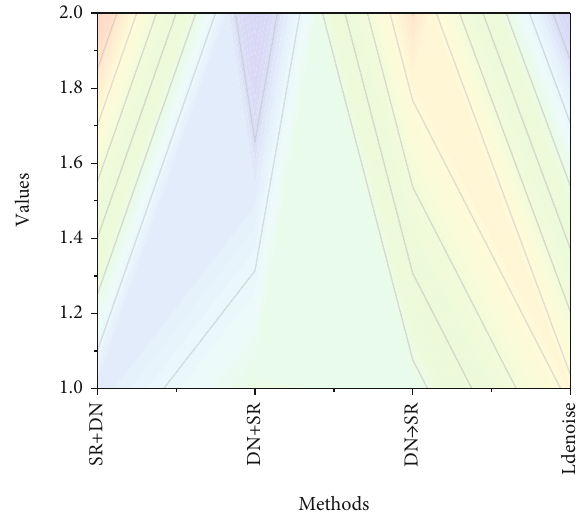
Figure 6: Quantitative comparison of denoising and super- resolution mixing